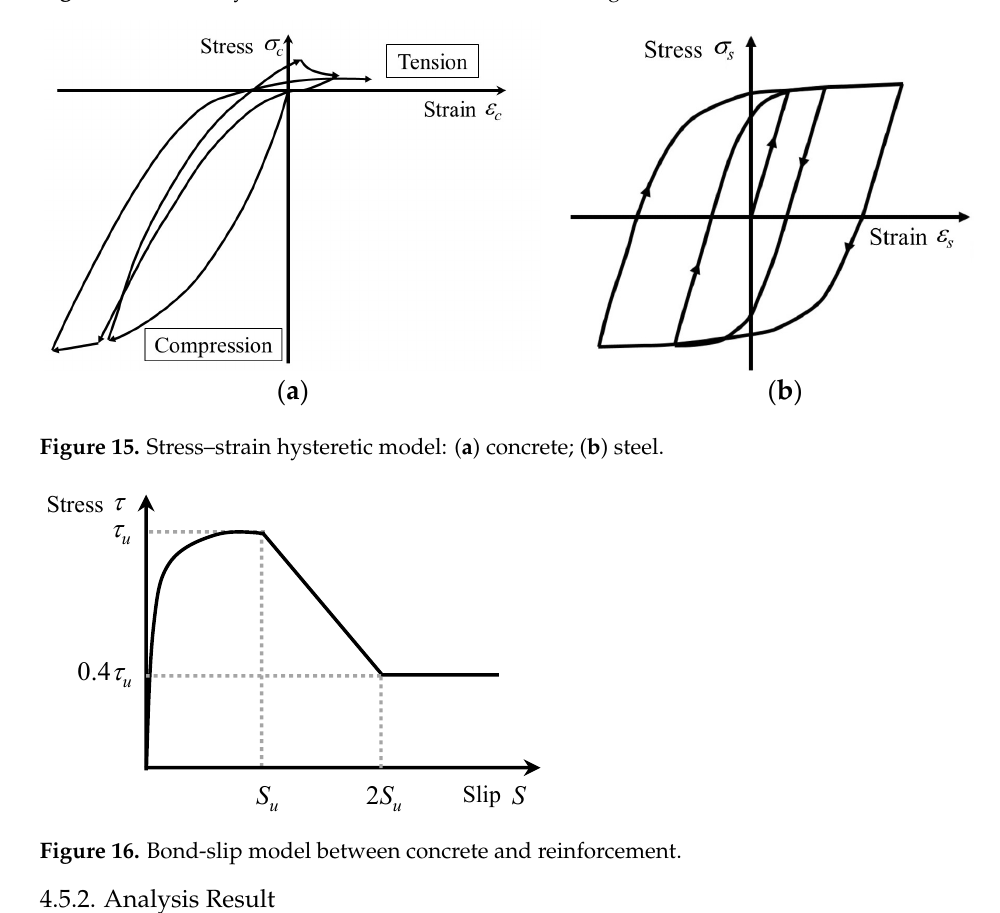
Figure 15. Stress–strain hysteretic model: ( a ) concrete; ( b ) steel.